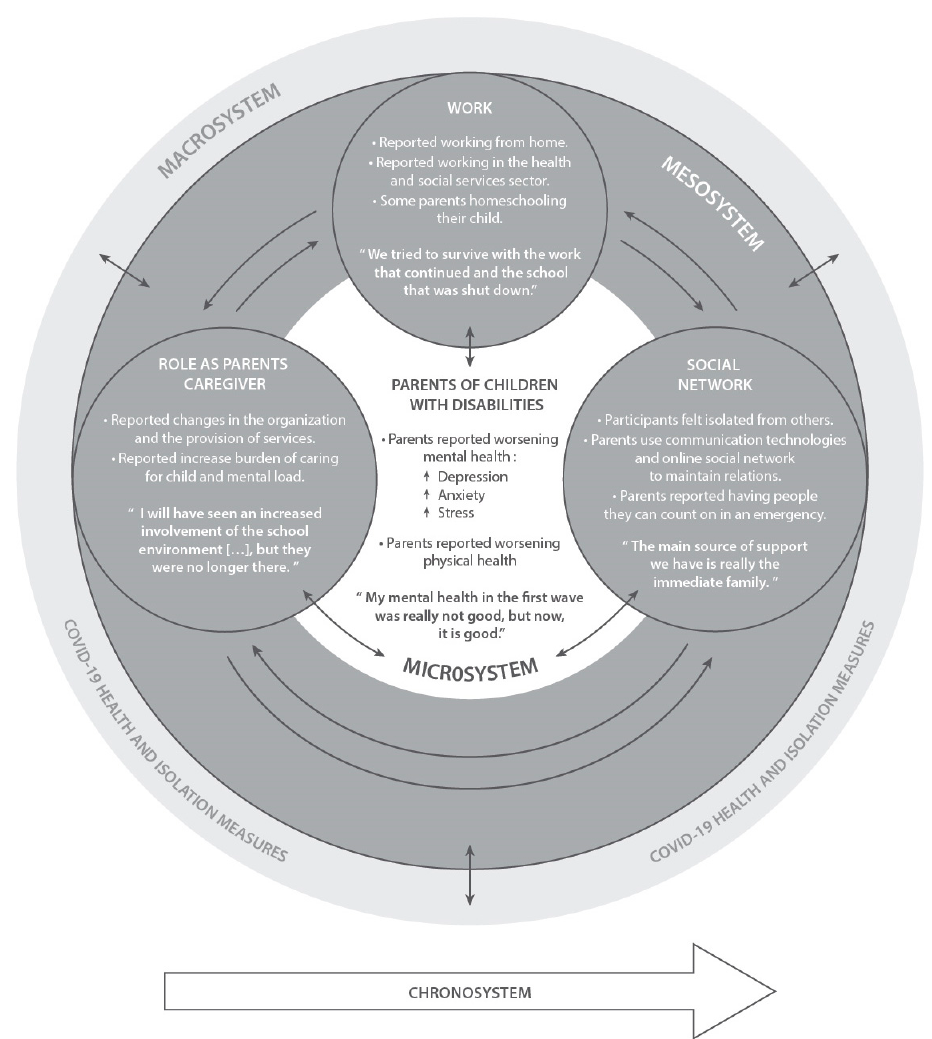
Figure 1. Summary of pandemic impacts on parents’ life according to Bronfenbrenner’s ecological systems theory.